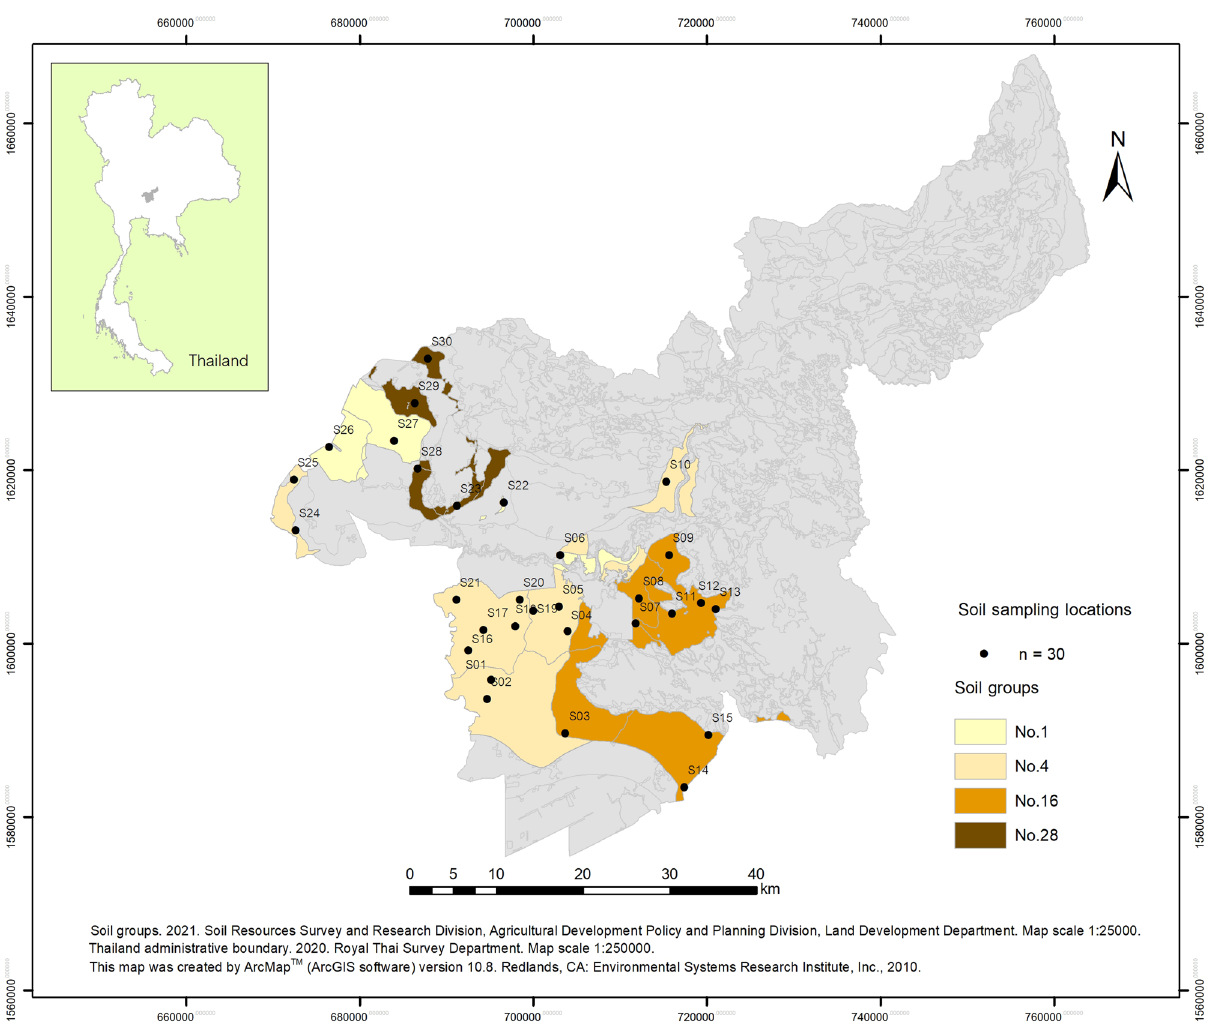
Figure 1. Sampling locations based on soil groups and the study area in Saraburi, Province,